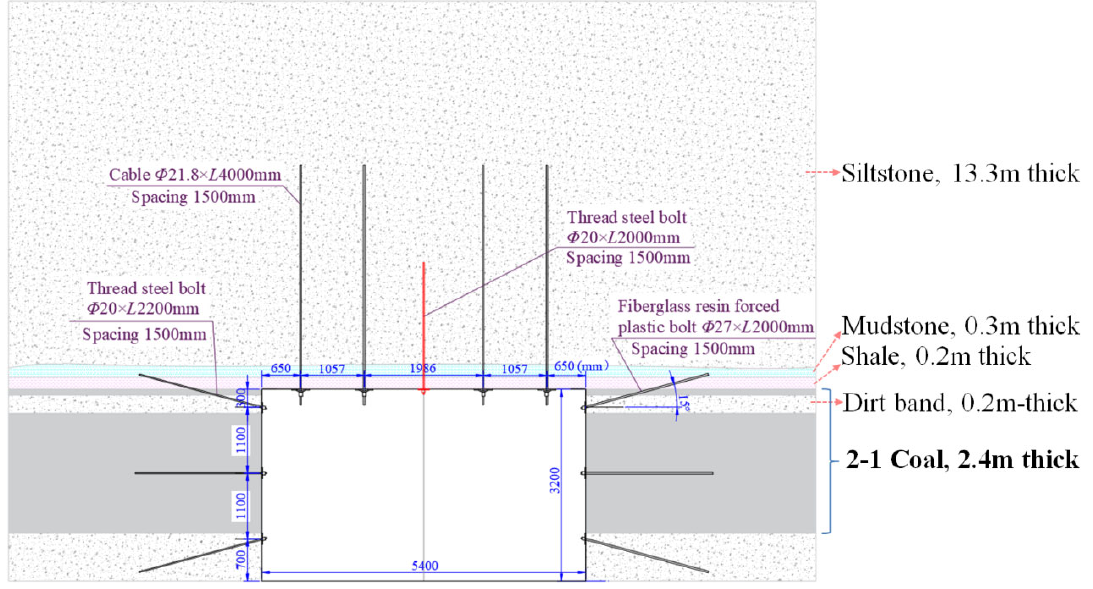
Figure 12. Cross ‐ boundary linkage control supporting scheme of the thick anchorage layer. Figure 12. Cross-boundary linkage control supporting scheme of the thick anchorage layer.